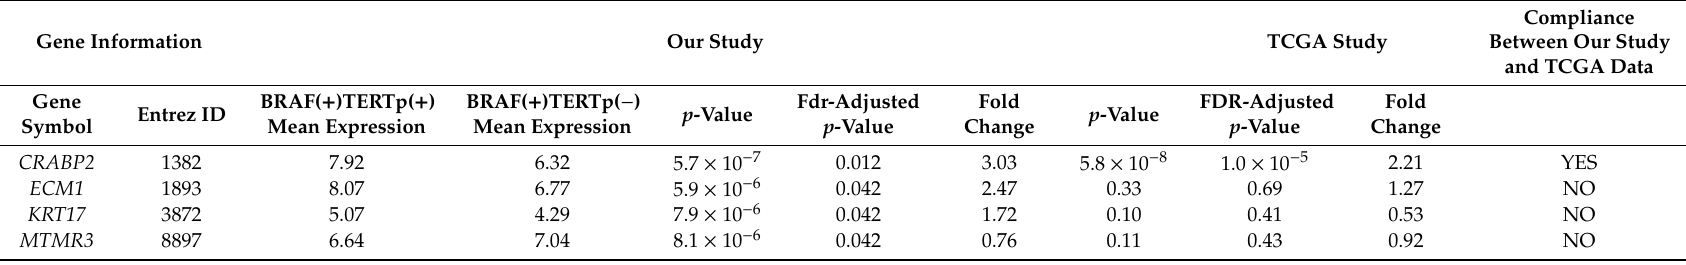
Table 4. Validation of genes di ff erentiating BRAF( + )TERTp( + ) and BRAF( + )TERTp( − ) PTCs performed on an independent set of PTC made available by the TCGA